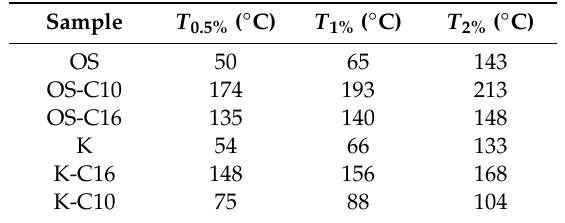
Table 4. T wt% values of ether-functionalized organosolv (OS) and Kraft (K) lignin samples from the TGA plot.